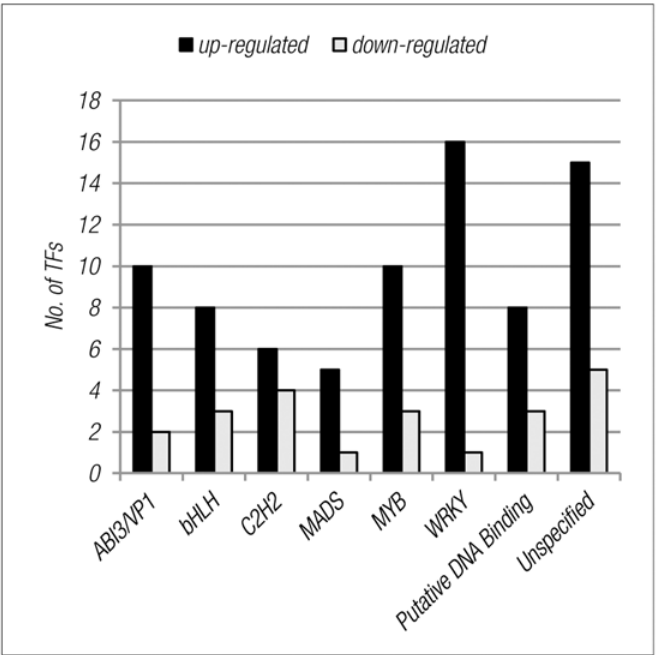
Fig 6. Distribution of differentially regulated transcription factors into highly represented transcription factor families.